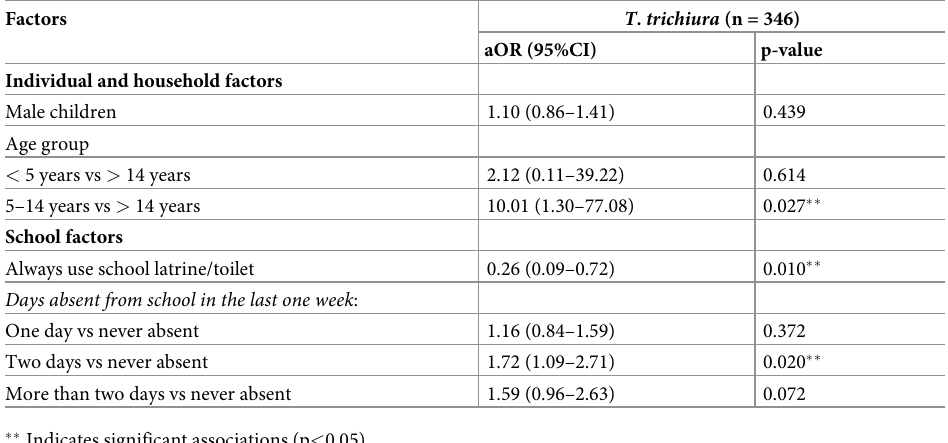
Table 11. Multivariable associations between WASH conditions and Trichuris trichiura infection among school children in Kenya after five rounds of